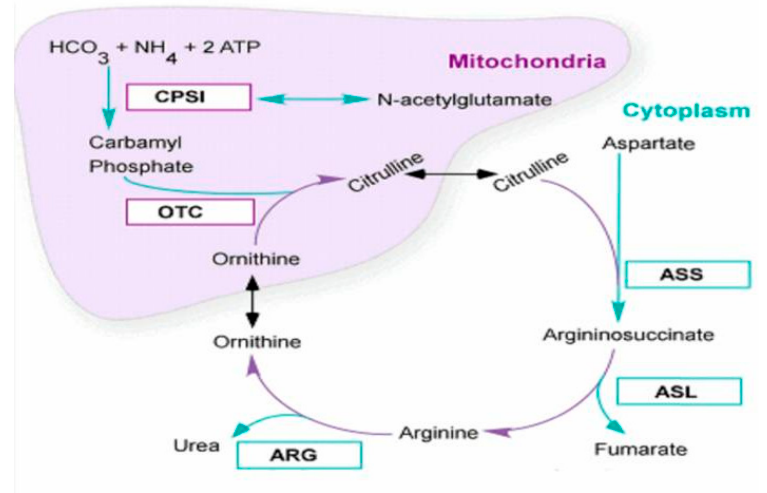
Figure 1. Urea cycle enzymes.